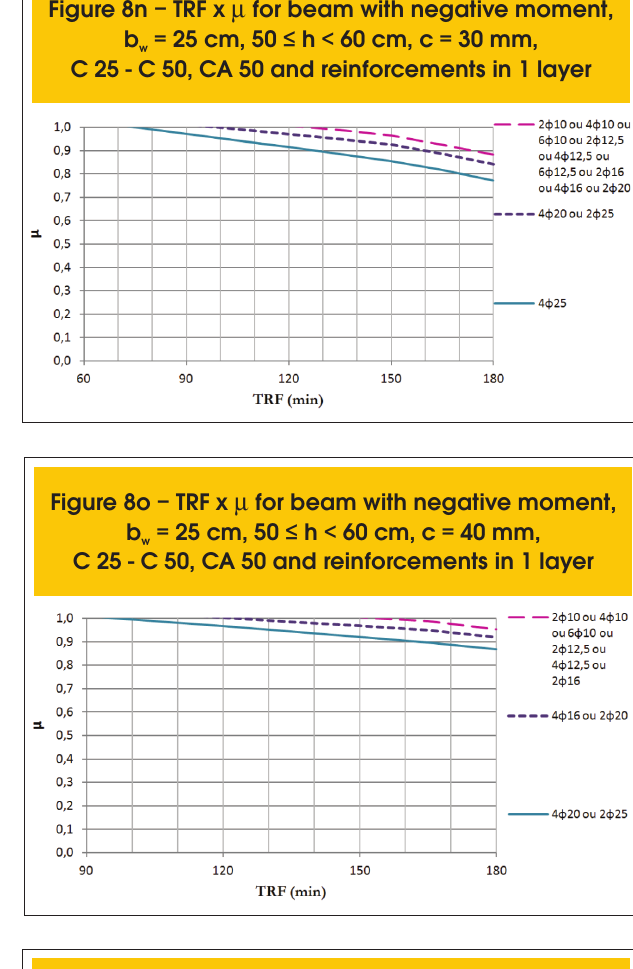
Figure 8m – TRF x m for beam with negative moment, b = 25 cm, 50 ≤ h < 60 cm, c = 25 mm, w C 25 - C 50, CA 50 and reinforcements in 1 layer